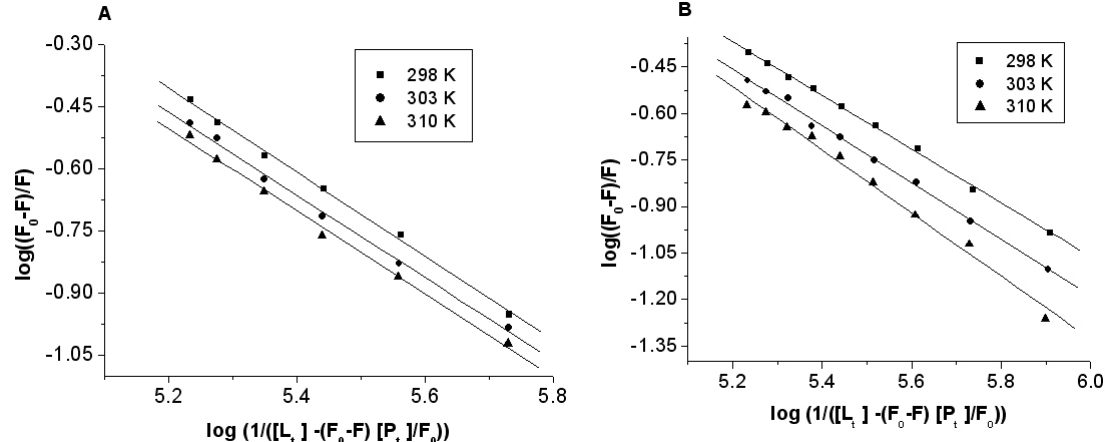
=286 nm; λ = 346 nm); R=0.998 (298 K); 0.997 (303 K); 0.997 ex em =286 nm; λ = 339 nm); R=0.980 (298 K); 0.996 (303 K); 0.990 (310 K) for ex em